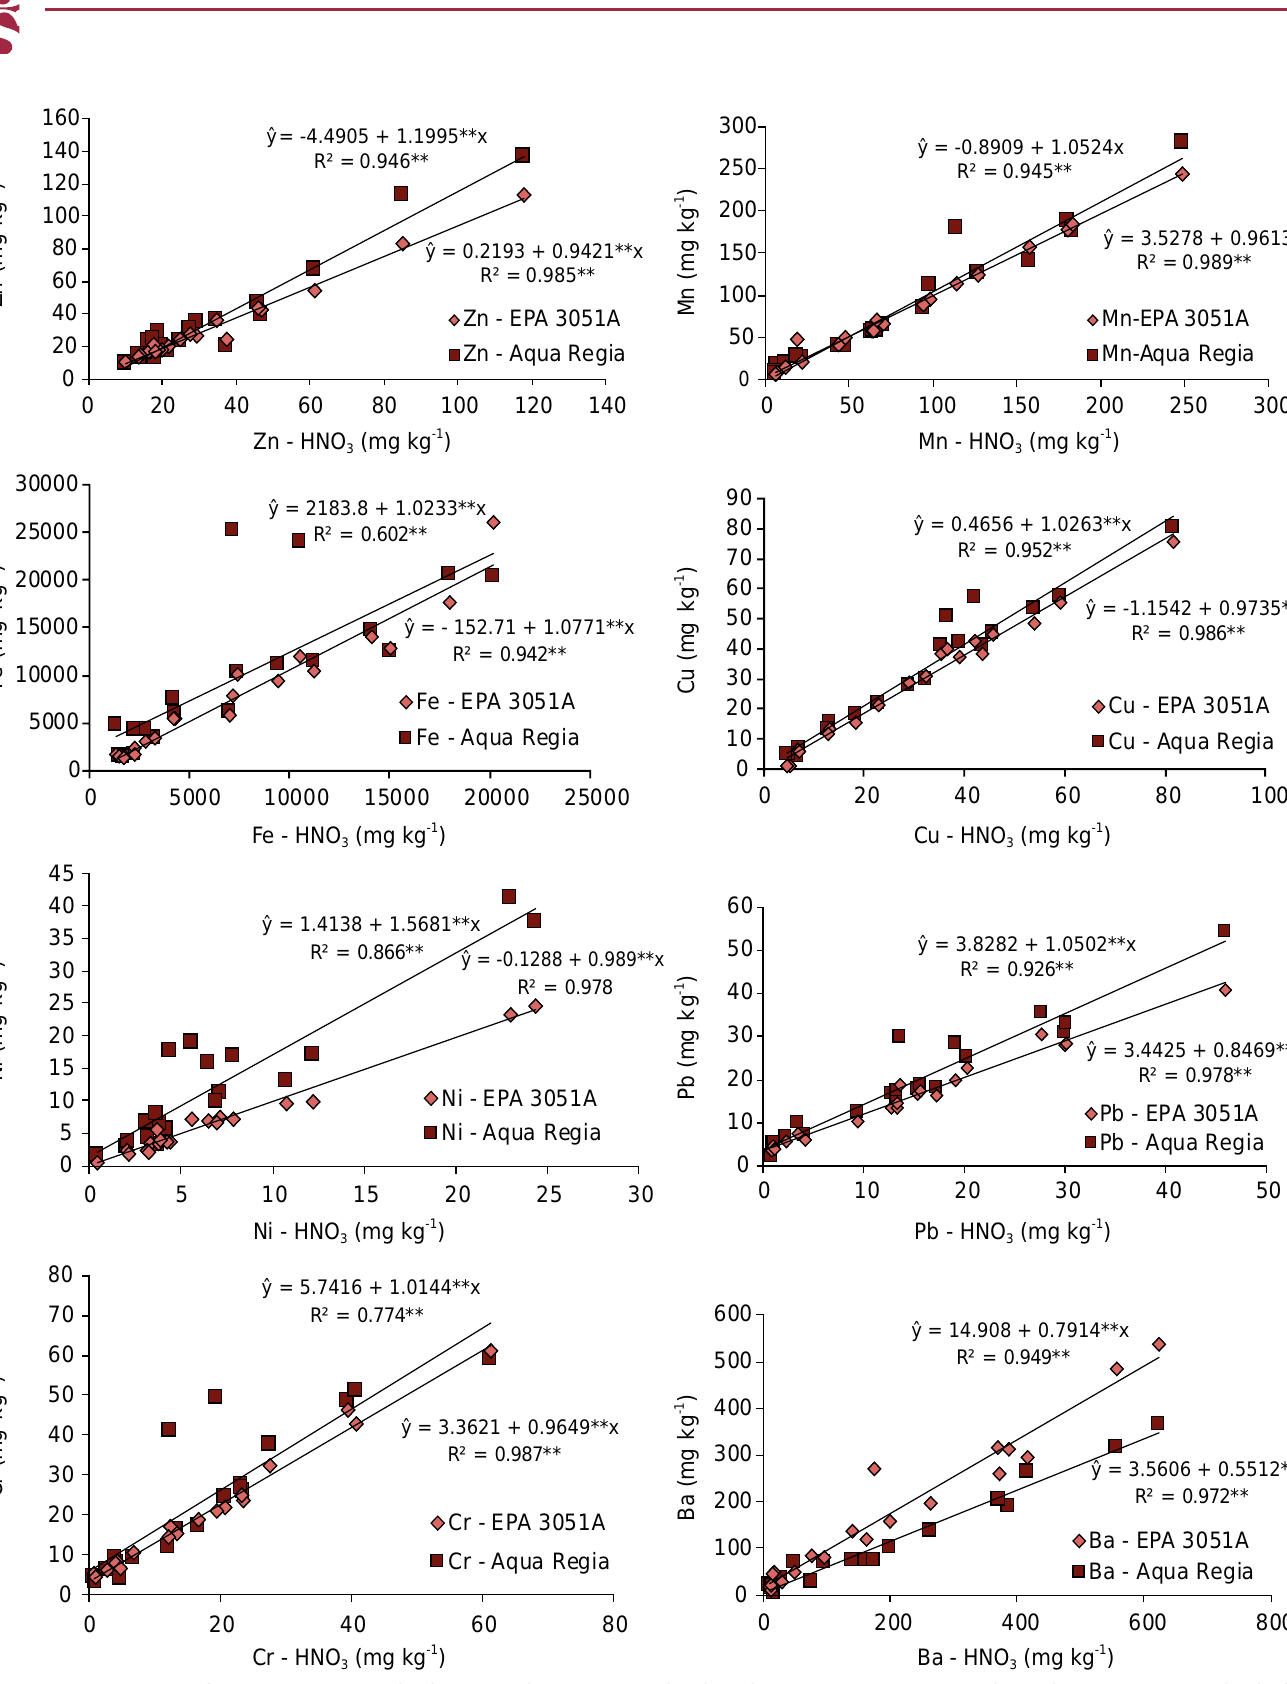
Figure 1. Contents of Zn, Mn, Fe, Cu, Ni, Pb, Cr, and Ba extracted using the EPA 3051, Aqua Regia and EPA 3051A methods for Histosols. ** : significant at 1 %